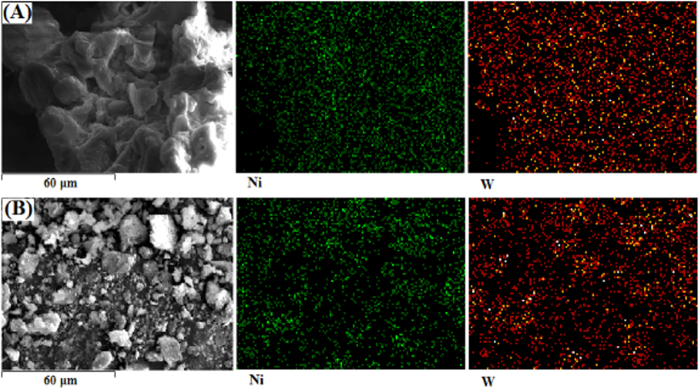
SEM and EDX elemental mappings for the synthetic Ni-PTA/Al2O3 catalyst (A) and Ni-PTA/Al2O3 powder (B).